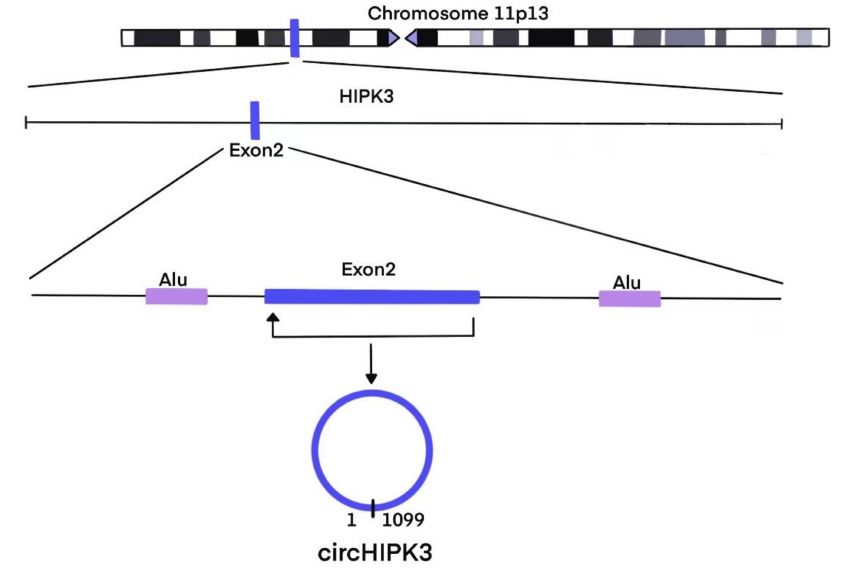
Figure 1. The biogenesis of